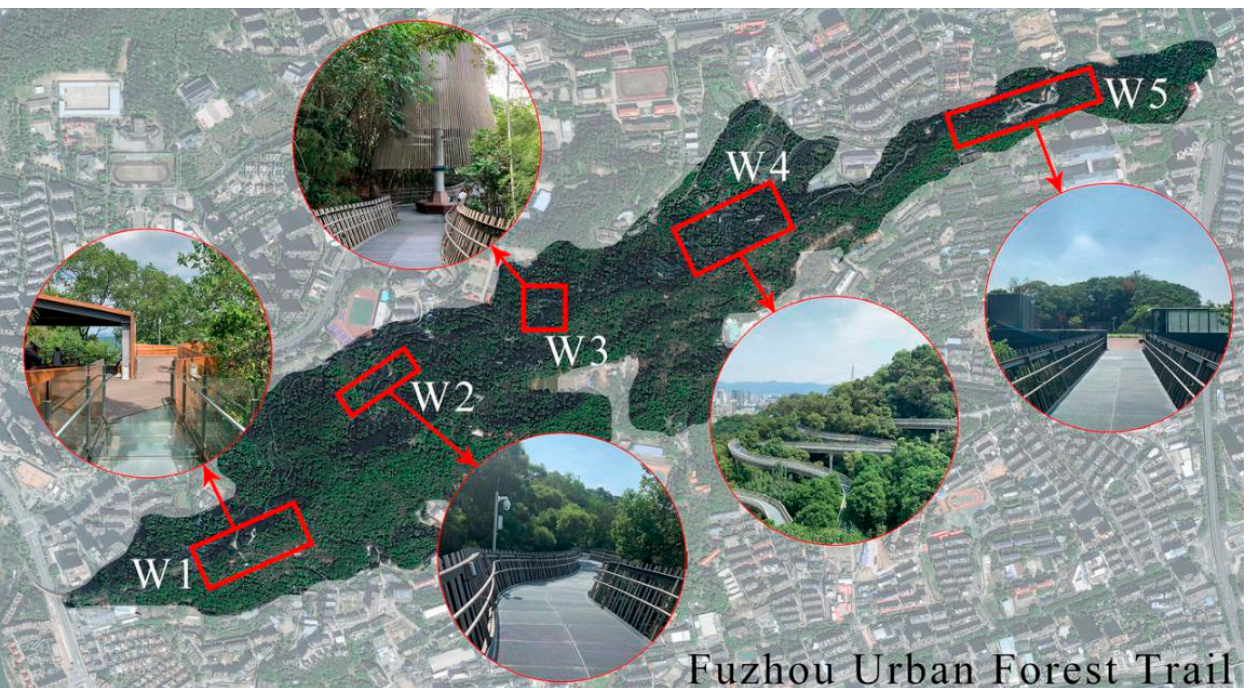
Figure 3. Location of five walking tour areas in Fuzhou Urban Forest Trail. (W1~W5, walking tour area numbers) Table 1. Study site descriptions of Fuzhou Urban Forest Trail.